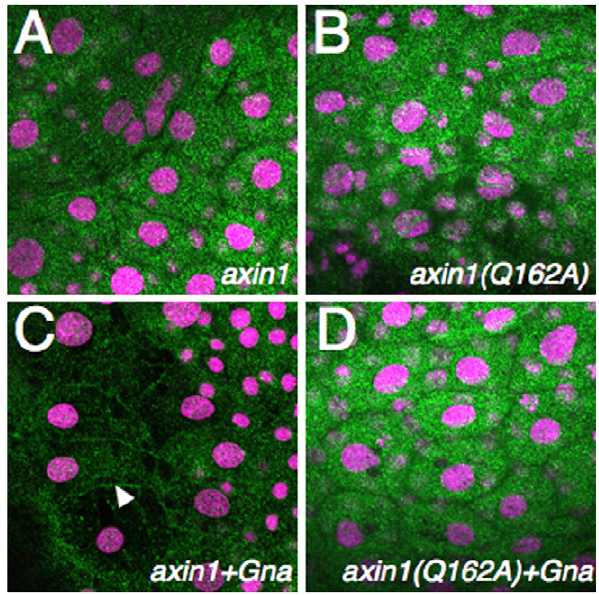
Figure 2. Axin1 Q162A does not interact with Gna at the plasma membrane. ( A–D ) Immunostaining against Myc showing localization of Axin1-Myc and Axin1(Q162A)-myc in zebrafish embryos, without (A, B) or with coexpression of Gnao (C, D). The arrowhead in C indicates membrane localization of Axin1 upon Gnao expression. Embryos were counterstained with TOPRO3 to show nuclei (purple).